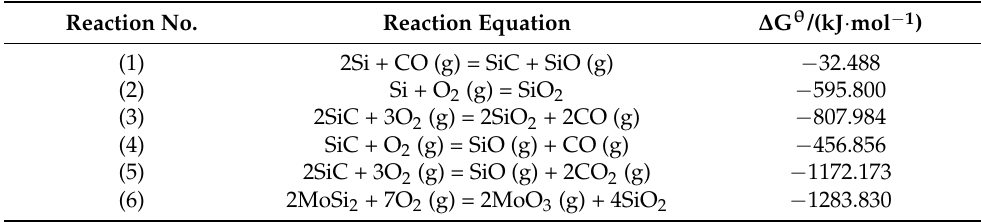
Table 2. Reactions and their Gibbs free energy during the oxidation process in SiC-MoSi 2 -Si coatings in 1773 K